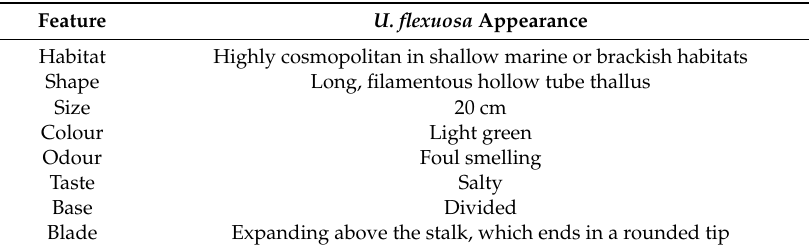
Table 1. Organoleptic features of Ulva flexuosa .